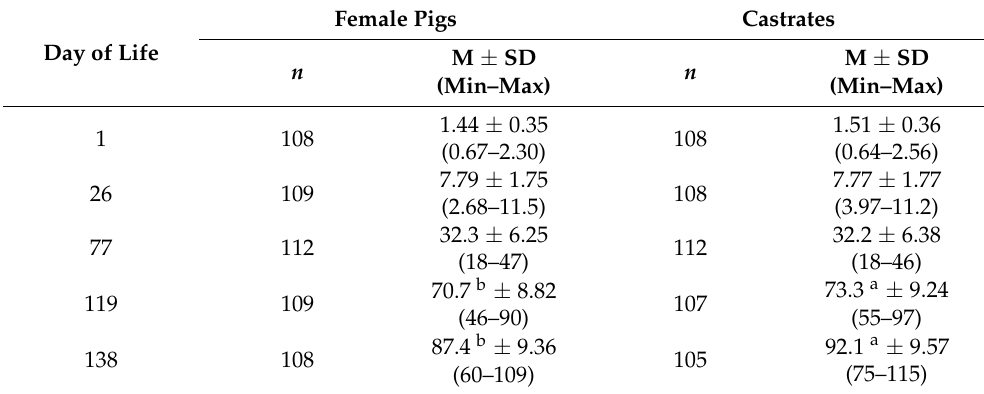
Table 4. Live weight of pigs (kg) from birth to